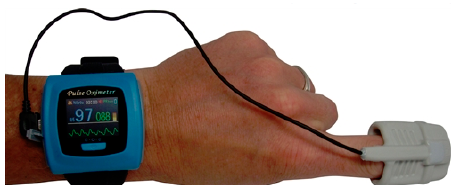
Figure 1. The CMS50FW wearable oxygen saturation (SpO2) and pulse rate device with wireless communication for real-time vital-sign monitoring.